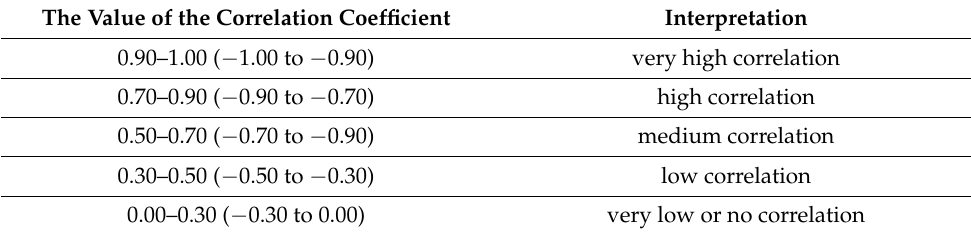
Table 2. Characteristics of Pearson correlation coefficient values. The Value of the Correlation